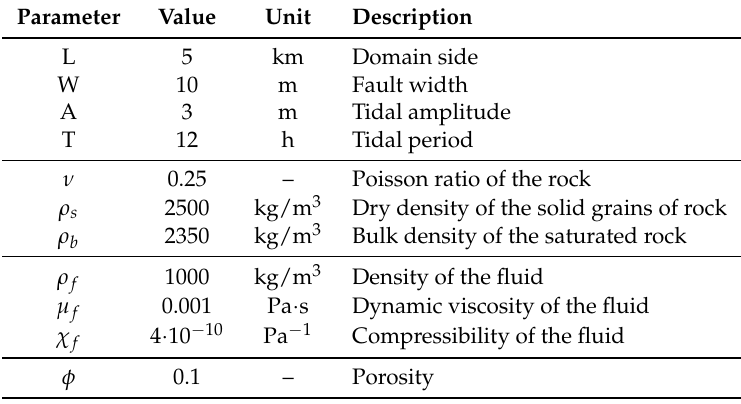
Table 2. Parameters of the 2D poroelastic models (Figures 4b,